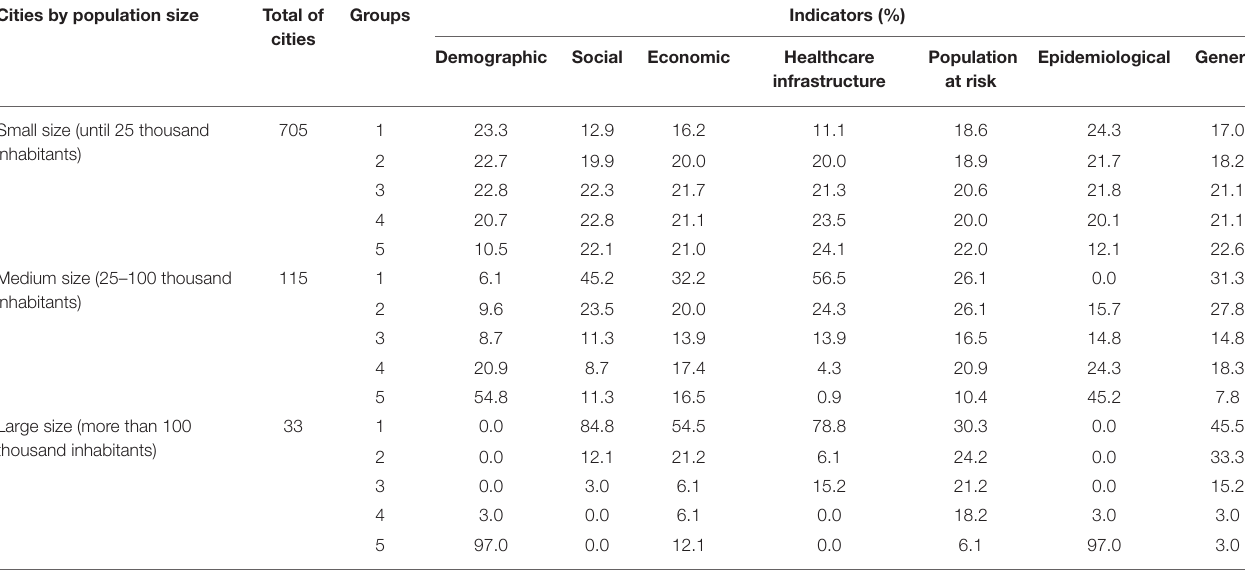
TABLE 4 | Results of the multi-criteria decision analysis according to the population size of municipalities in the state of Minas Gerais and their vulnerability classification, in accordance with the grouping of indicators used in the multi-criteria decision analysis for COVID-19. Cities by population